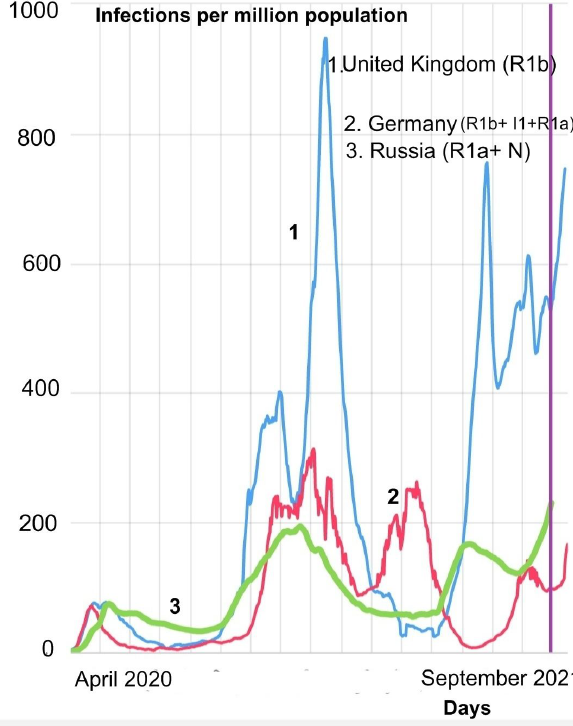
Figure 5. Infections per million following national vaccination pro- grams. Blue line – Great Britain (74% of the vaccinated